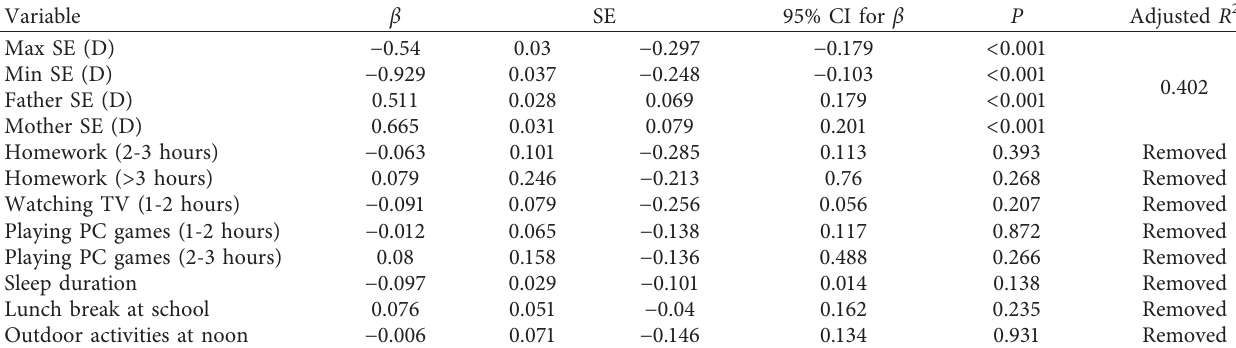
Table 3: Multiple regression analysis using 2623 families to assess environmental and genetic model in myopia.